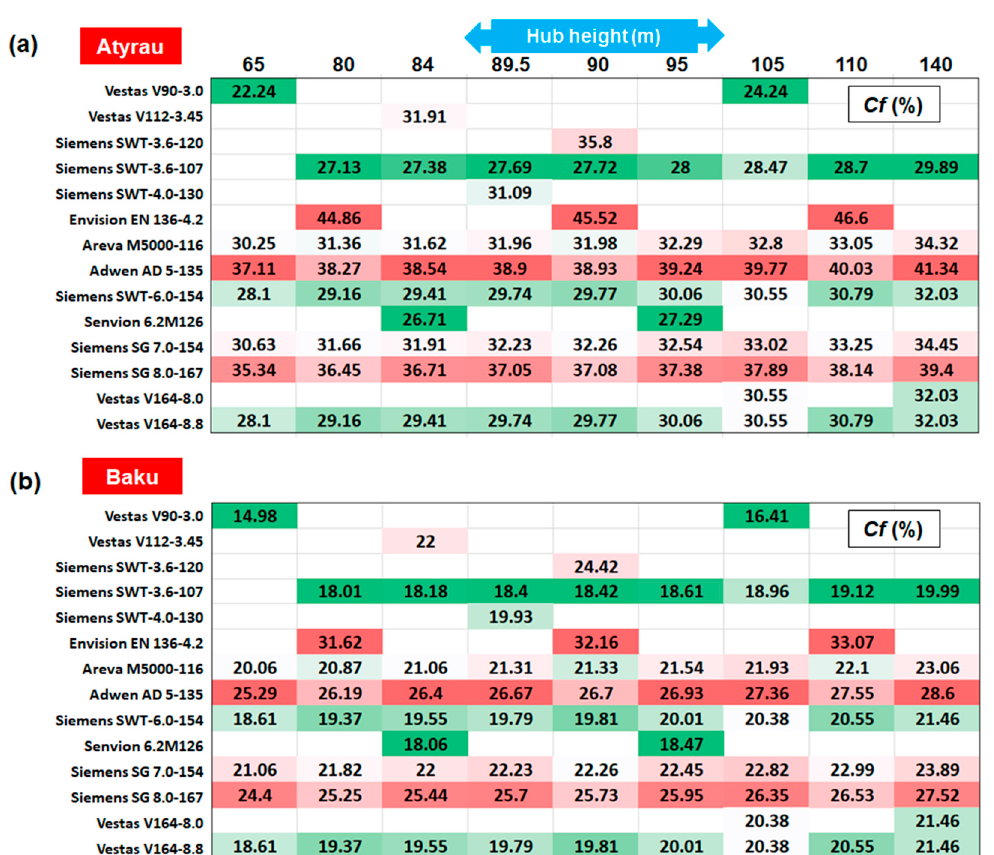
Figure 10. The capacity factor (%) reported for the full time distribution, considering the sites: ( a ) Atyrau; ( b ) Baku. The points are located at a distance of 5 km from the shoreline.